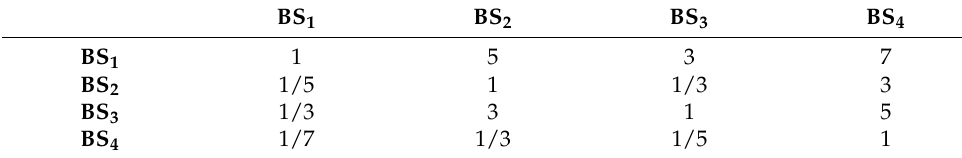
Table A5. The pairwise comparison matrix C 5 .